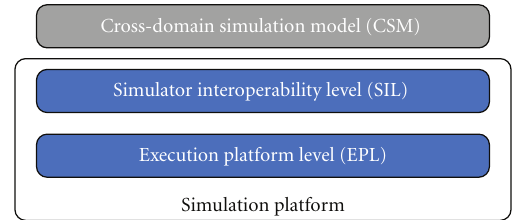
Figure 2: Simulation platform.